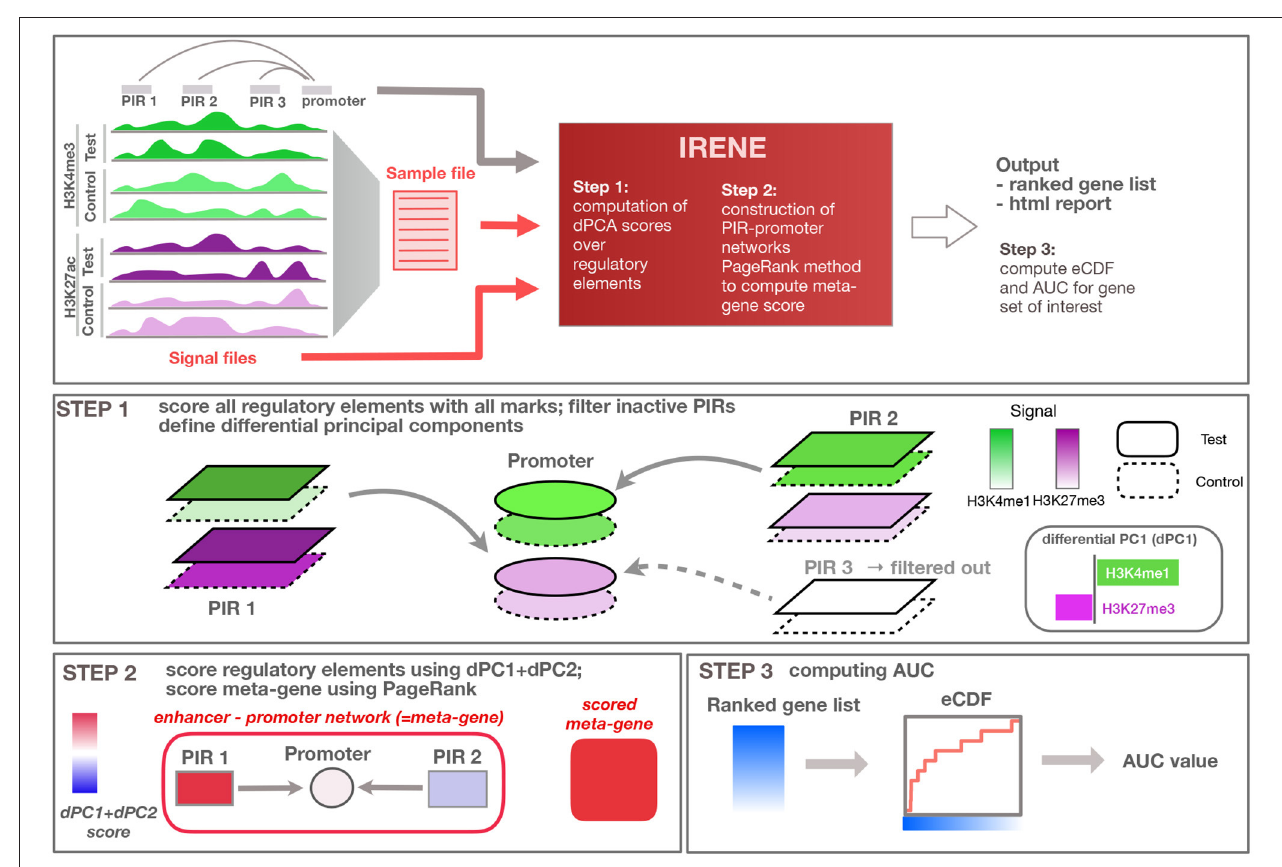
FIGURE 1 | Overview of the method. General overview of the input/output of the IRENE method; user defined input is indicated in red, while input provided by the method (e.g., regulatory loci and interactions) are displayed in gray. Step 1: Regulatory elements are scored using all epigenetic modifications, and related to the target gene. Step 2: Epigenetic alterations are scored using the first dPC and combined using PageRank into an integrated meta-gene score. Step 3: Ranked gene lists based on the score are converted to eCDF curves showing the enrichment of a given gene set within the top-ranked genes, and corresponding area under the curve (AUC) values are